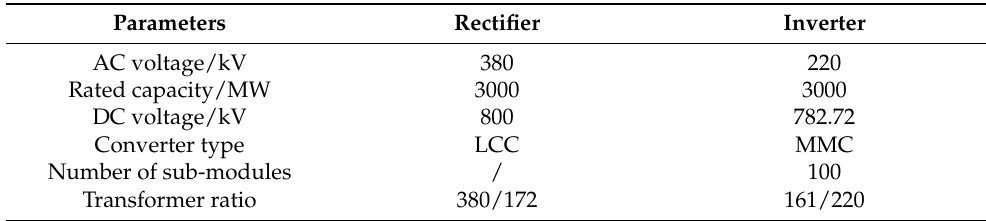
Table 2. Basic operating parameters of proposed